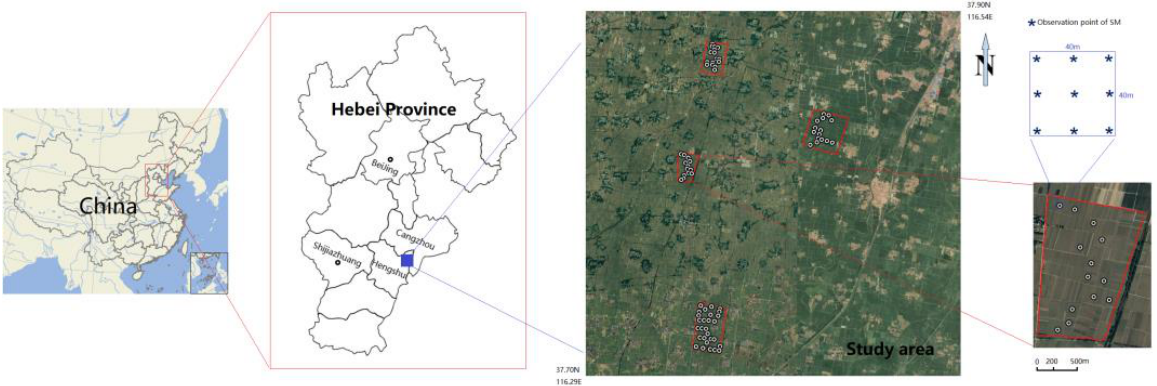
Figure 1. Location of the study area and distribution of field observation points.